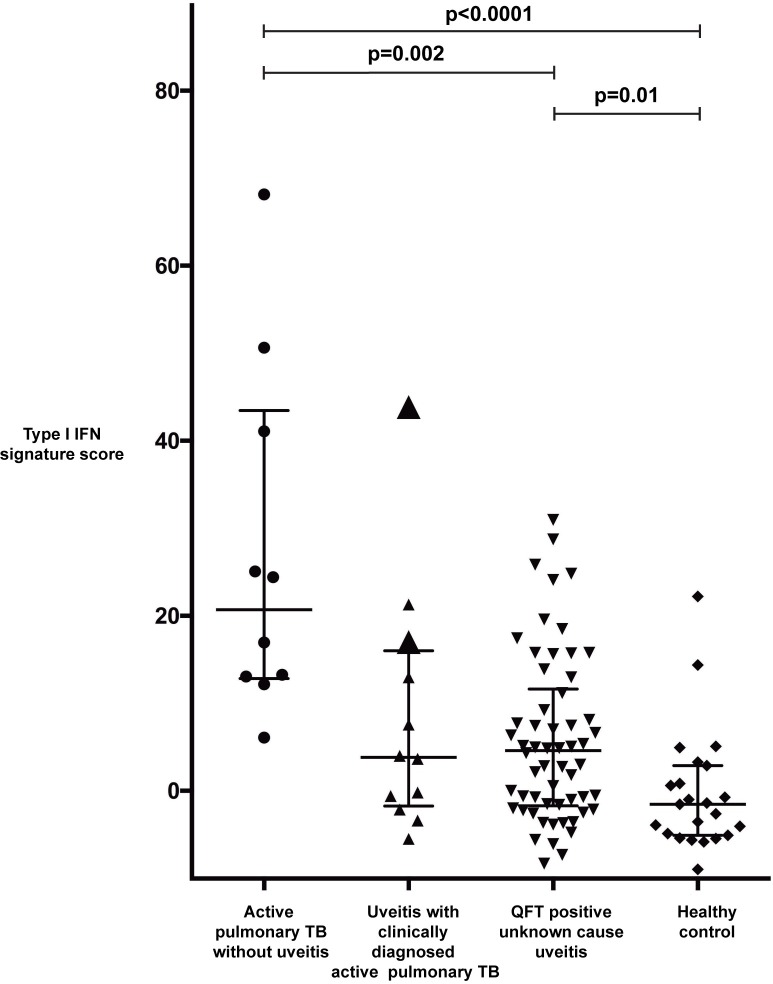
Scatter plot of type 1 IFN signature scores for the four study groups.A type 1 IFN gene signature score was calculated for every individual patient sample based on the expression of the 10-gene set. Each point represents one individual. Horizontal bars indicate the median value within a group. Enlarged triangles within the TB uveitis group represent the two individuals within that group with a sputum stain positive for Mtb. Statistical significance was assessed using the Kruskal-Wallis test, and subgroup analyses were performed with Dunn’s multiple comparison test.